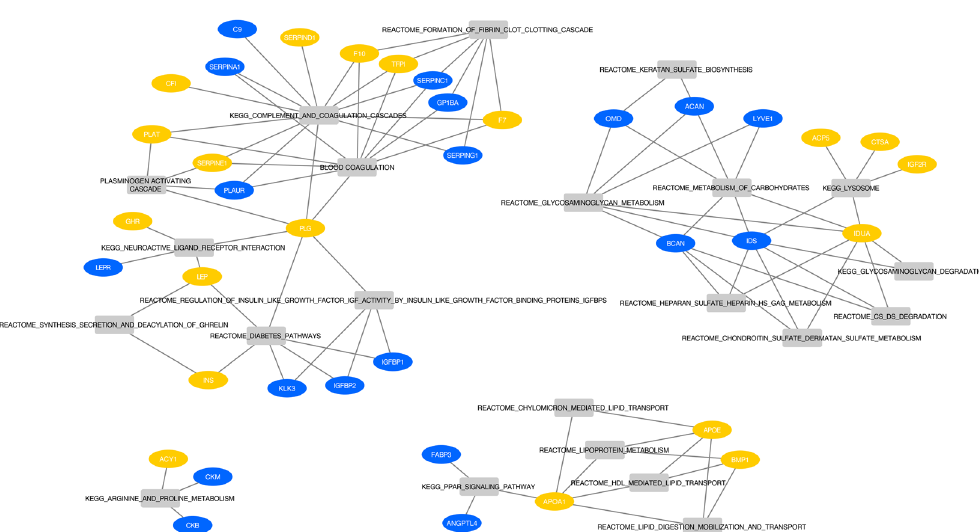
Figure 6. Pathways significantly enriched in proteins whose changes in levels during LCD distinguish responders from non-responders. This network displays the connections between the constituent proteins (shown as ellipses) and the enriched biological pathways (rectangles); the node color indicates whether protein levels at LCD termination (CID2) are more pronounced in non-responders (yellow edges) or responders